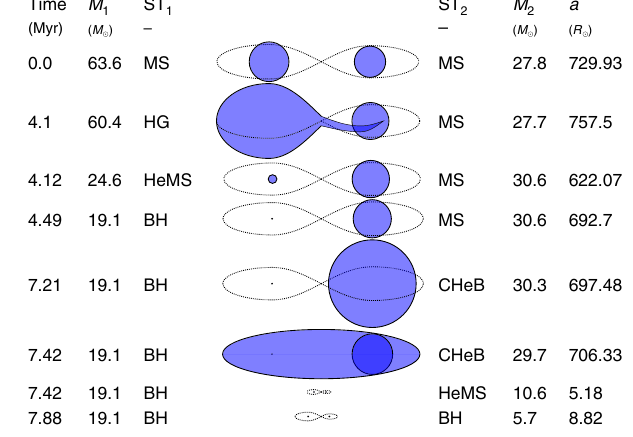
Figure 3 | Formation of GW151226. Typical formation of GW151226 at 10% solar metallicity in our model, as described in the Results. The columns show the time, the masses and stellar types of the primary and secondary, M 1 , ST 1 and M 2 , ST 2 respectively, and the semi-major axis a . Some intermediate stages of the evolution are omitted for